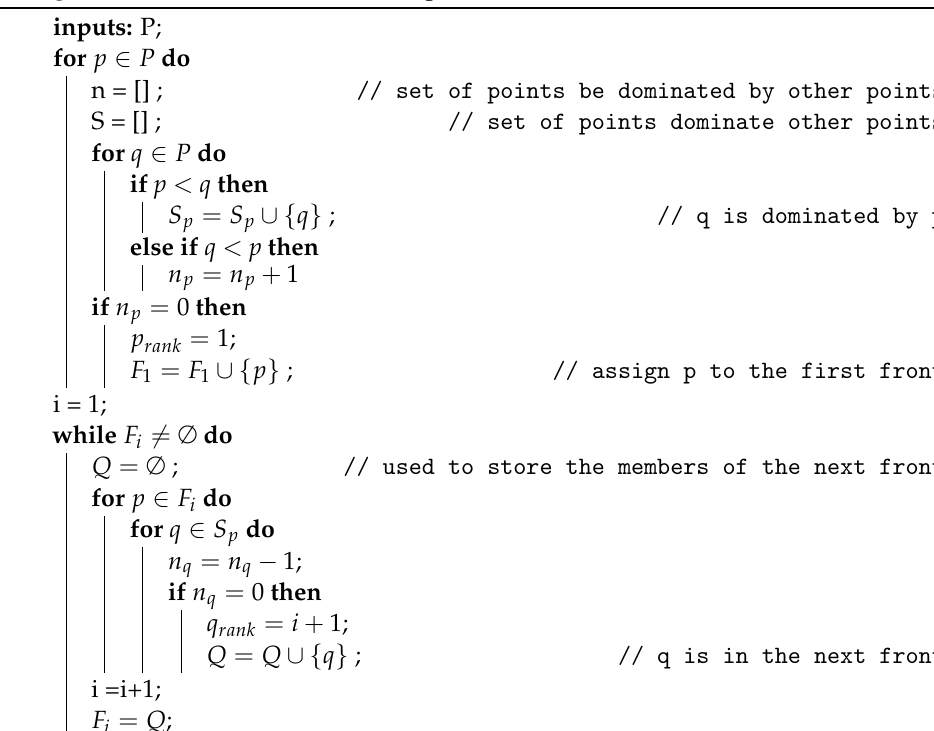
Algorithm 1: Non-dominated